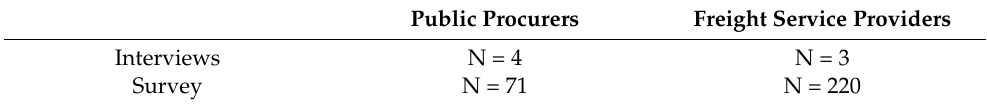
Table 1. Overview of data